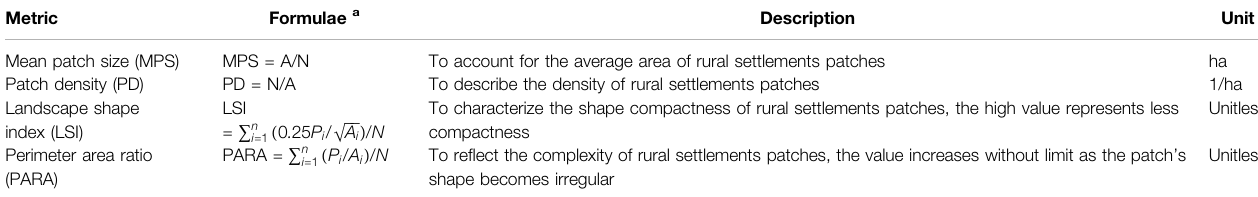
TABLE 1 | Calculation formula and description of the landscape metrics.